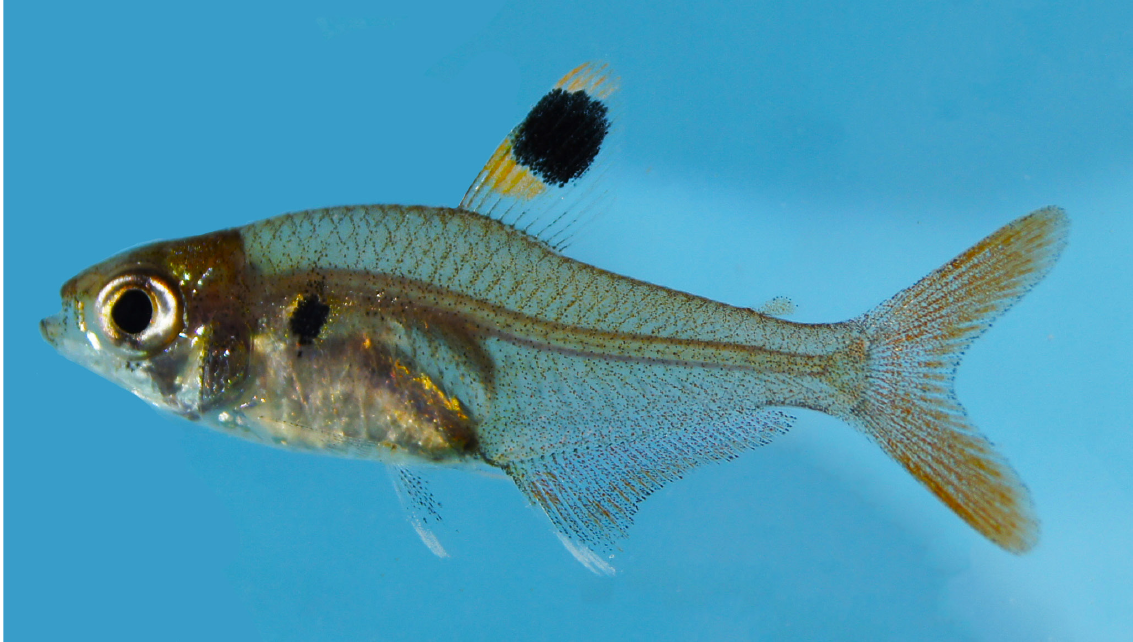
Fig. 4. Hyphessobrycon geryi Guimarães, Brito, Bragança, Katz & Ottoni sp. nov. , holotype (CICCAA 02403), 28.3 mm SL; Brazil: Maranhão State: Lower Tocantins River